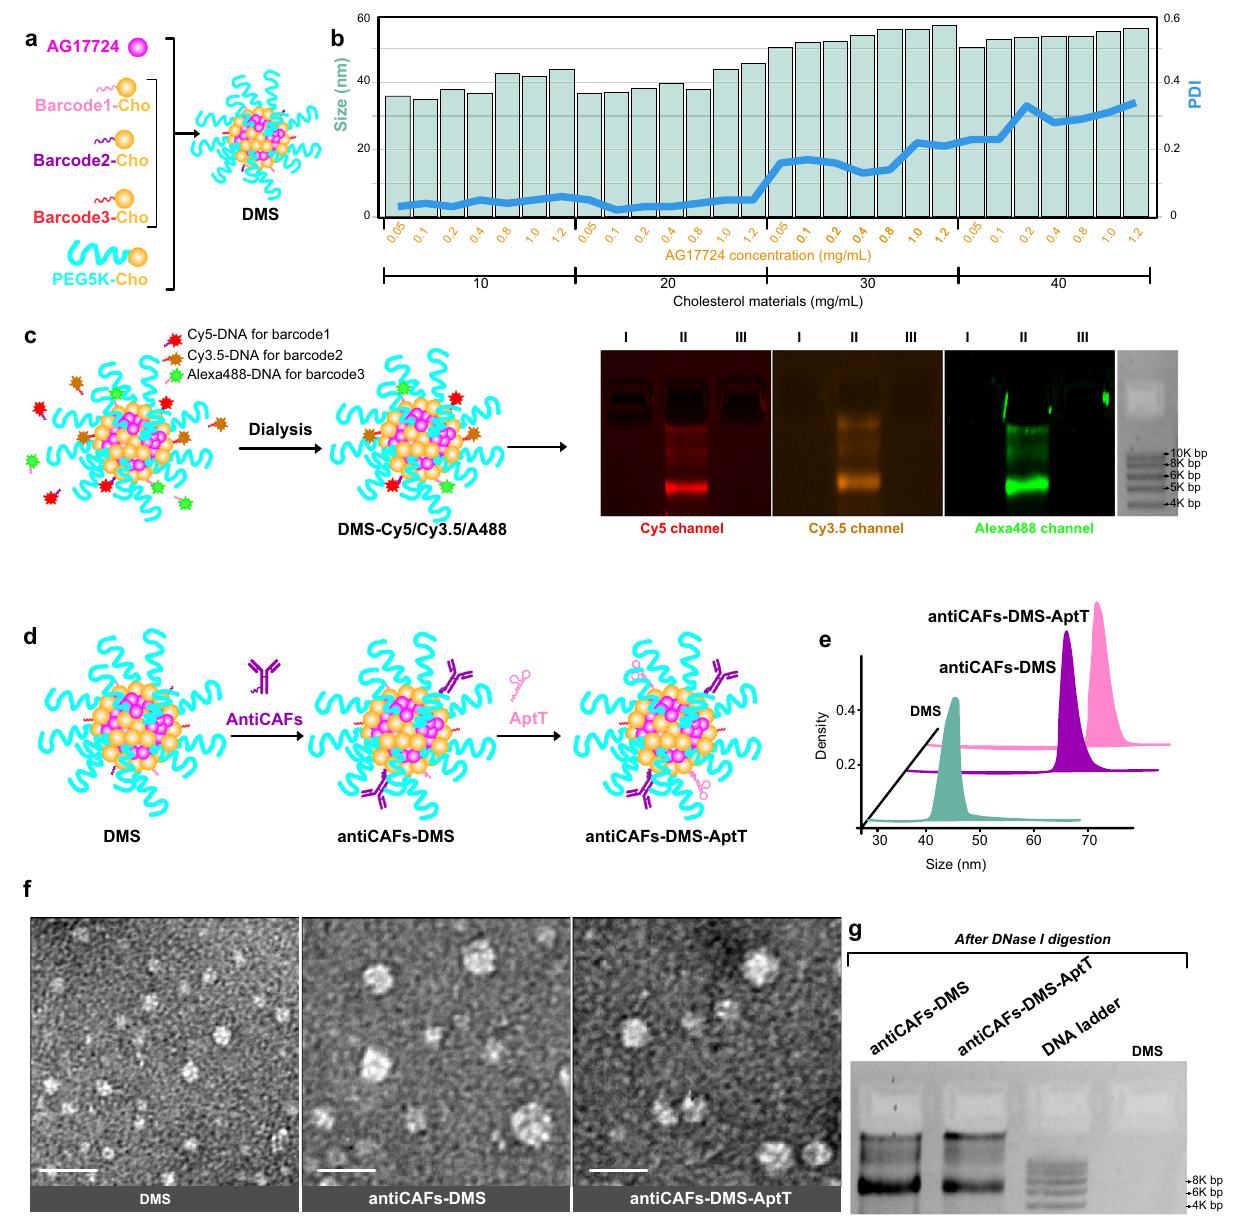
Fig. 2 | Characterization of formulations. a Schematic compositions and self- assembly ofDMS. b Corresponding sizes and PDIs of DMS preparedfrom different concentrations of AG17724 and cholesterol materials. Three independent repeti- tionsgotsimilarresults. c ValidationofDNAbarcodesonDMSviausing fl uorescent probe-labeledcomplimentaryDNAoligos.I,DMS;II,DMS-Cy5/Cy3.5/A488;III,DMS incubated with Cy5-scrambled DNA, Cy3.5-scrambled DNA, and A488-scrambled DNA. Three independent repetitions got similar results. d Schematic work fl ow to